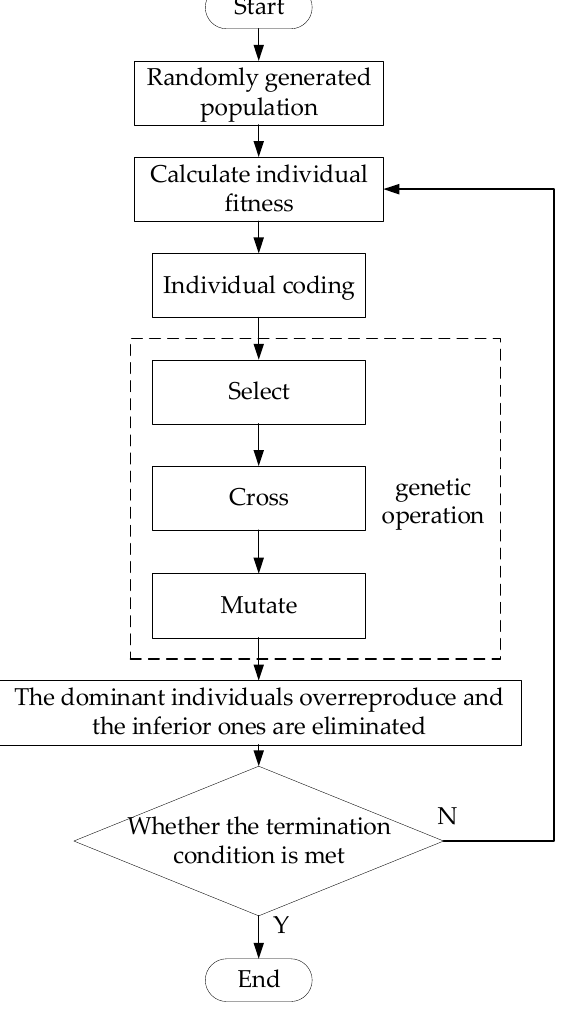
Figure 4. Flowchart of improved genetic algorithm.